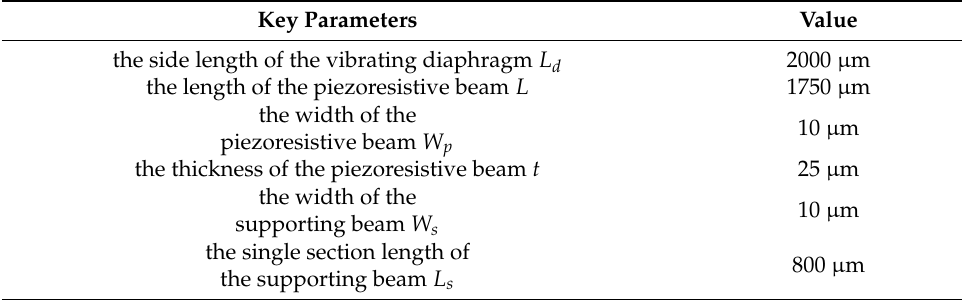
Table 1. The key parameters of the sensor.